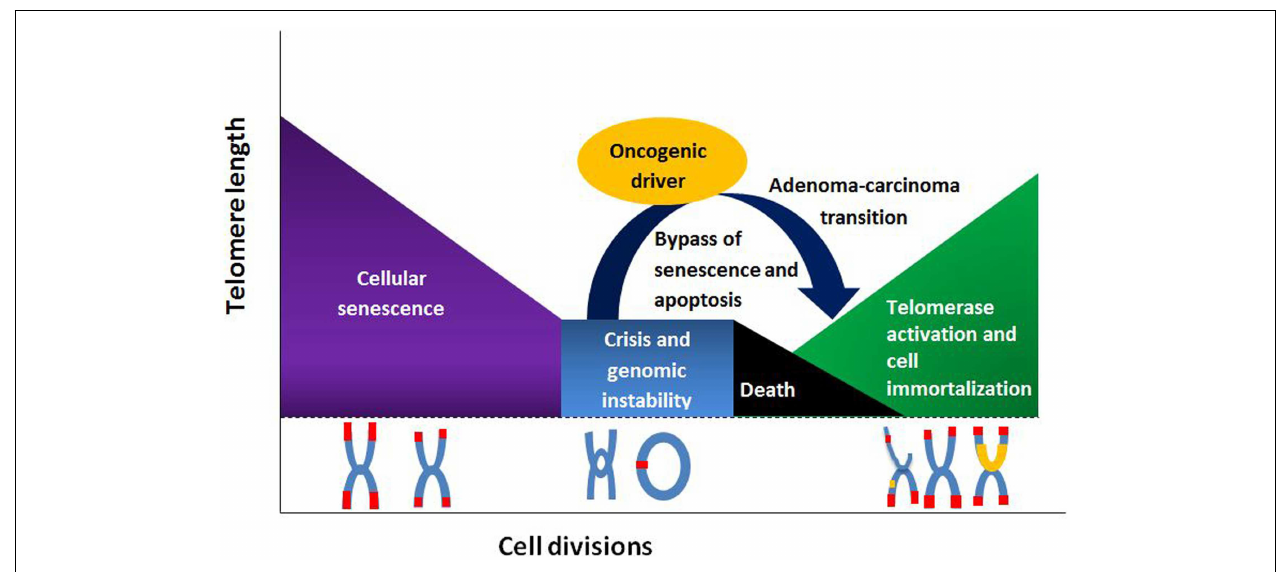
FIGURE 1 |Telomere length and its relationship to cell division, senescence, and senescence by-pass